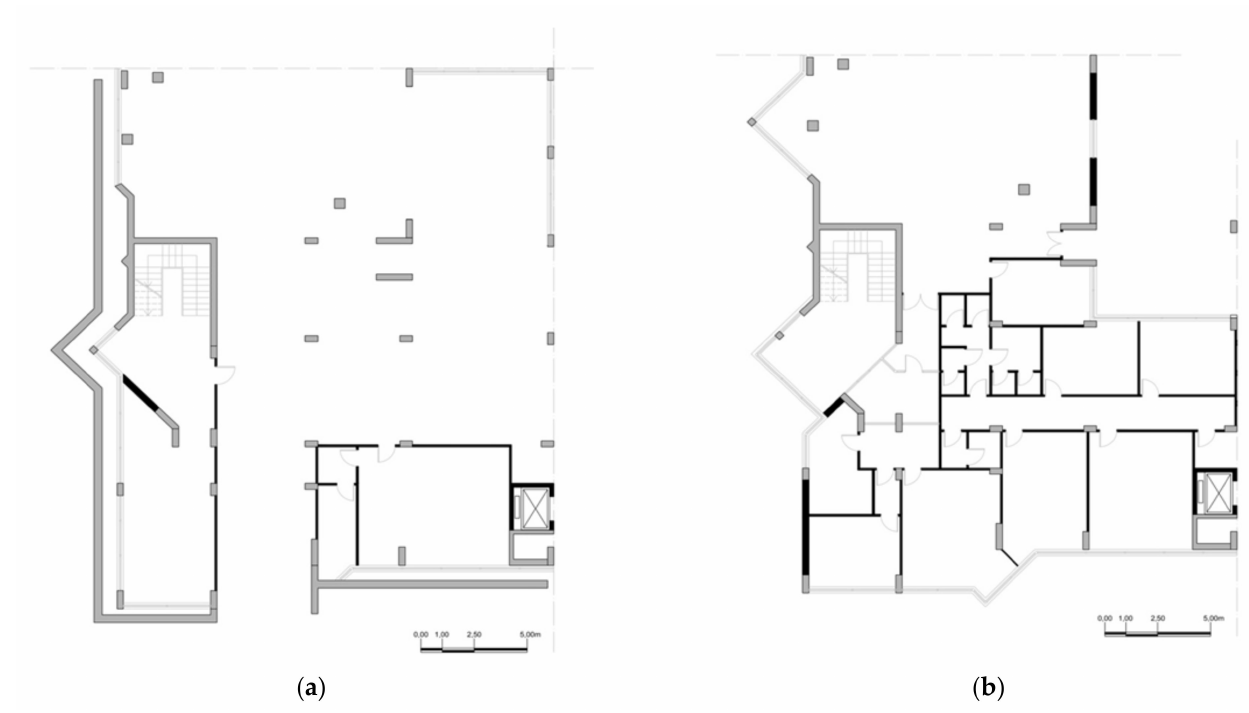
Figure 2. Principal façade of the “Municipal Headquarters” of Palagianello.